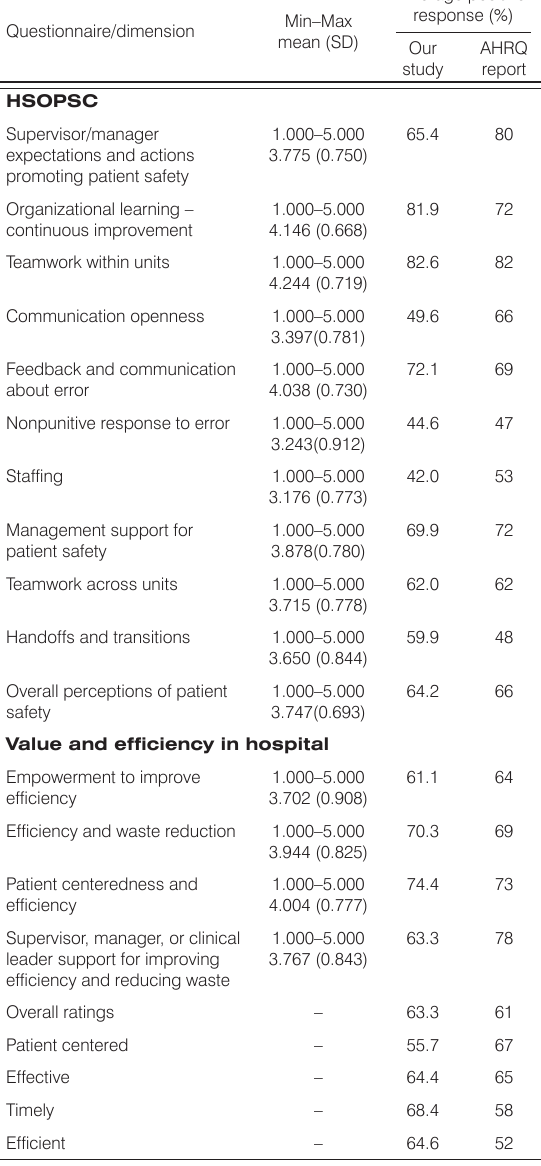
Table 1. HSOPSC scores and value and efficiency in